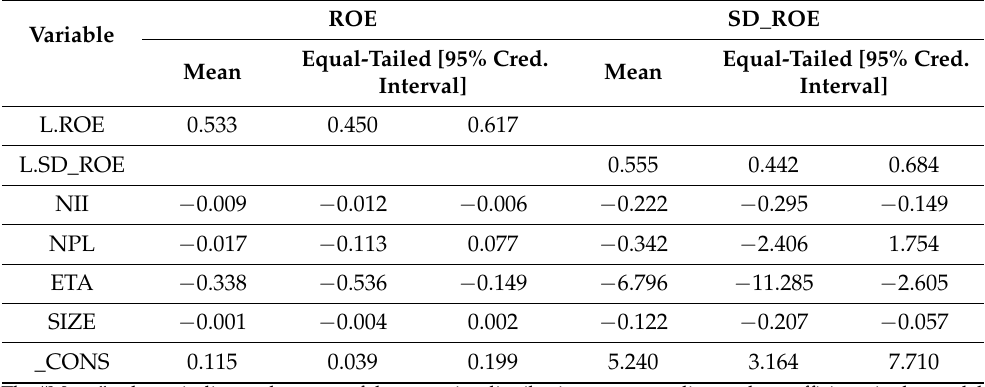
Table 5. Model estimation results using the Bayesian method with ROE, SD_ROE.